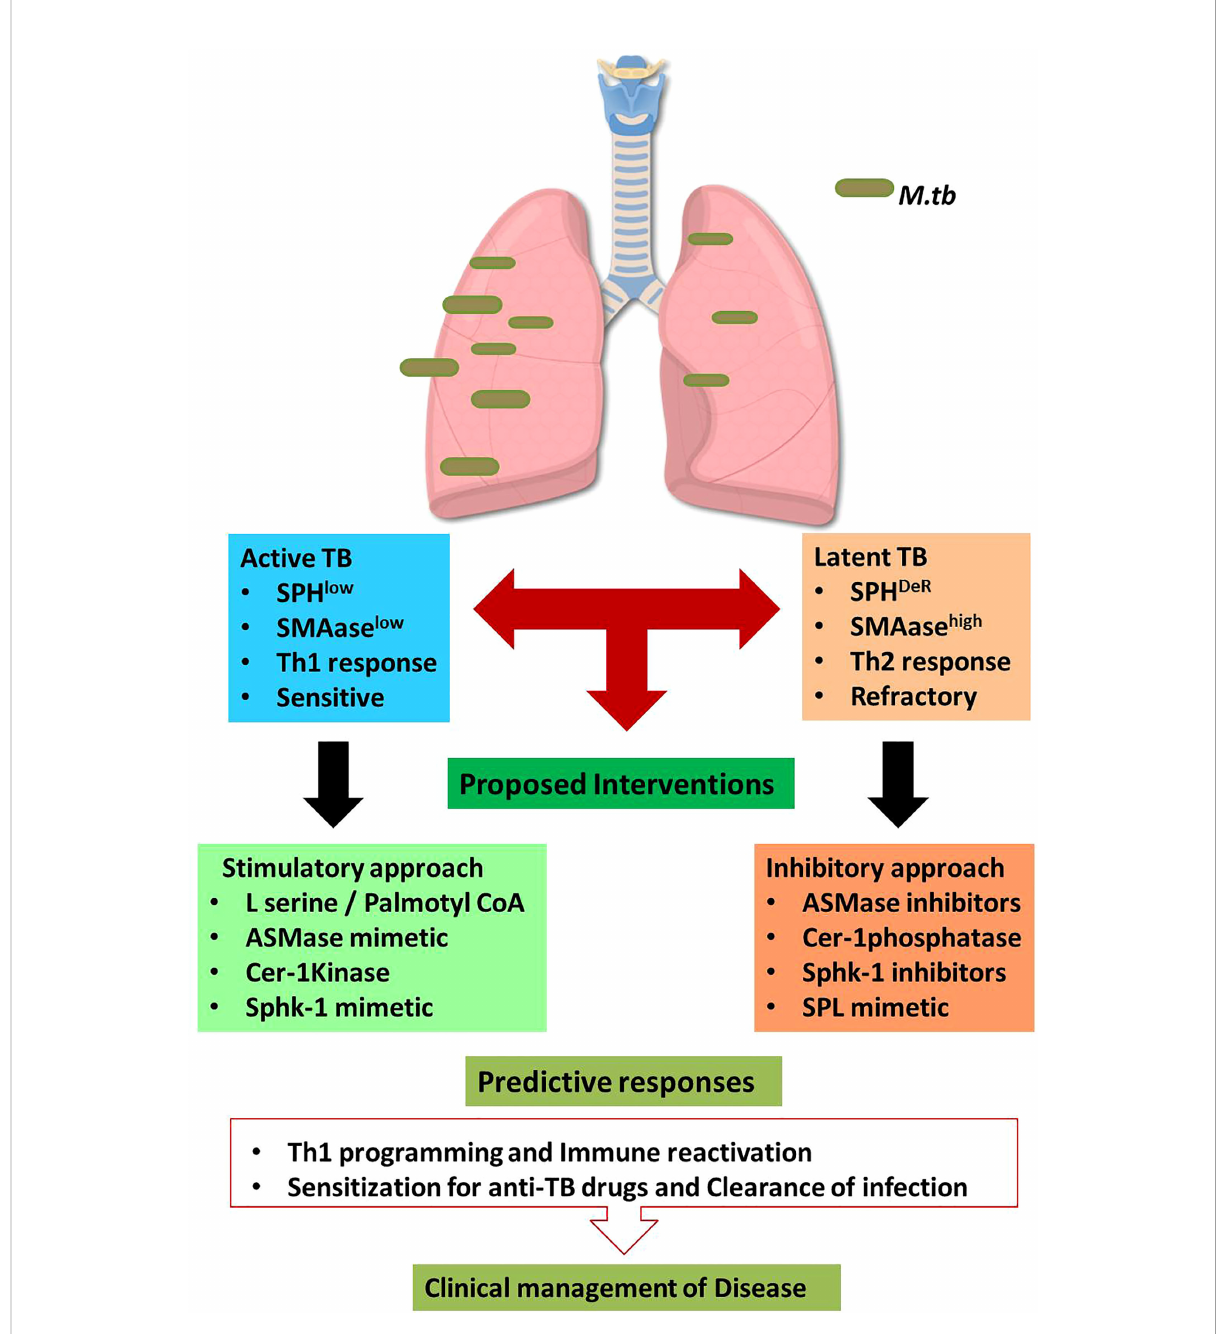
FIGURE 1 Sphingolipid based approaches for managing tuberculosis.The proposed hypothesis suggests the dual impact of sphingolipids on active and latent tuberculosis. During Active TB, sphingolipids are consumed therefore boosting sphingolipids by indicated interventions may favor host in clearing the bacterial burden. On contrast, latent TB is characterized by accumulation of distinct Sphingolipids derivatives which are involved in refractoriness of host. Thus in such conditions, mitigating sphingolipid levels would augment protective immunity in host. Such approach is anticipated to enhance the sensitivity of patients for 1 st Gen anti-TB drugs. This approach is translationally feasible and warrant intense